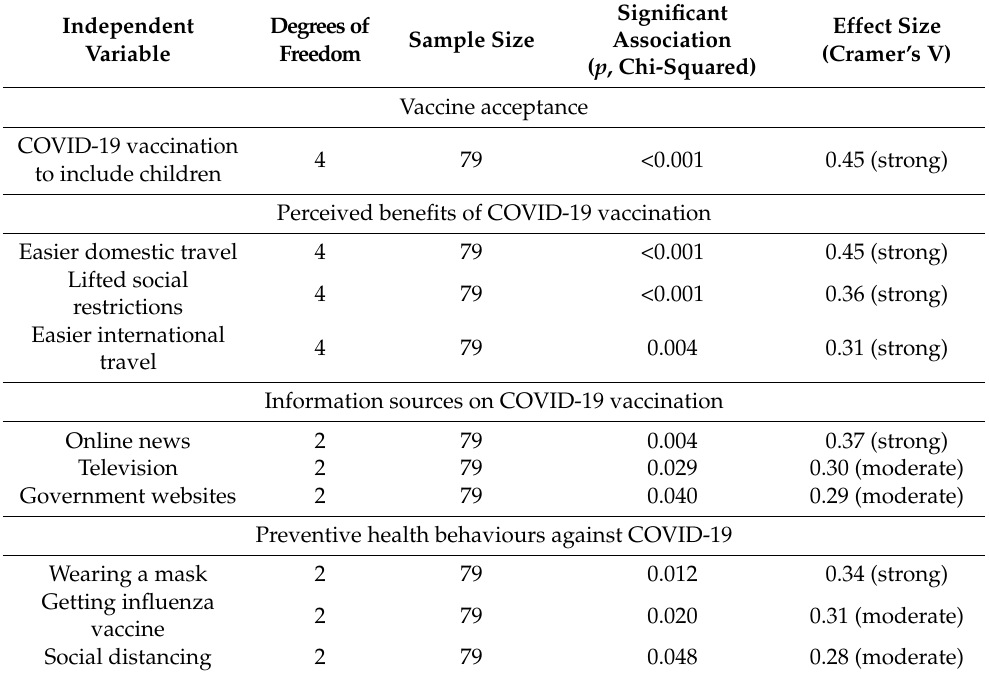
Table 3. Significant associations with intention to be vaccinated against COVID-19.